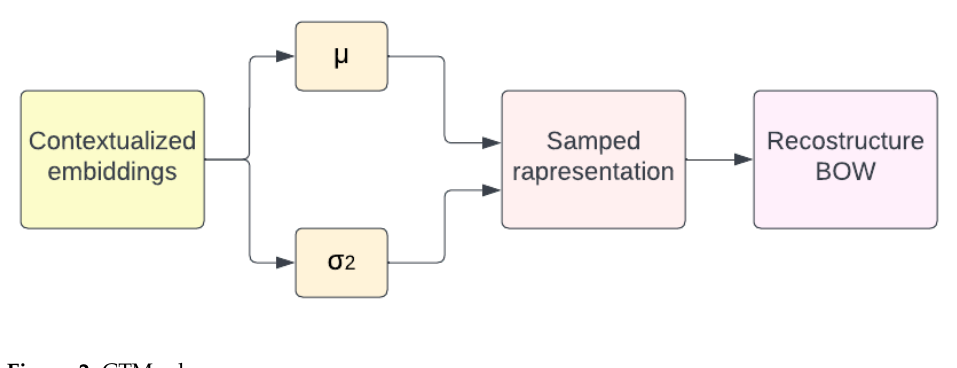
Figure 2. CTM schema.